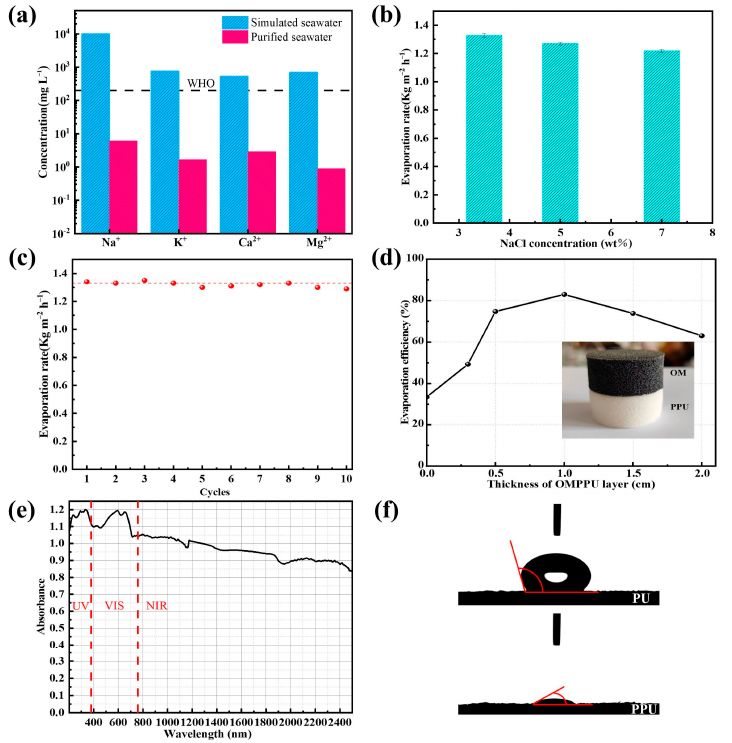
Figure 4. ( a ) The concentrations of different ions in simulated seawater and purified water ( b ) Evaporation rate of OMPPU under different brine concentrations. ( c ) Evaporation rate of OMPPU in 10 cycles. ( d ) Effect of the thickness of OM layer on the evaporation efficiency of OMPPU evapo- rators. ( e ) Solar absorption property of the OMPPU. ( f ) Contact angles of PPU before and after the function of